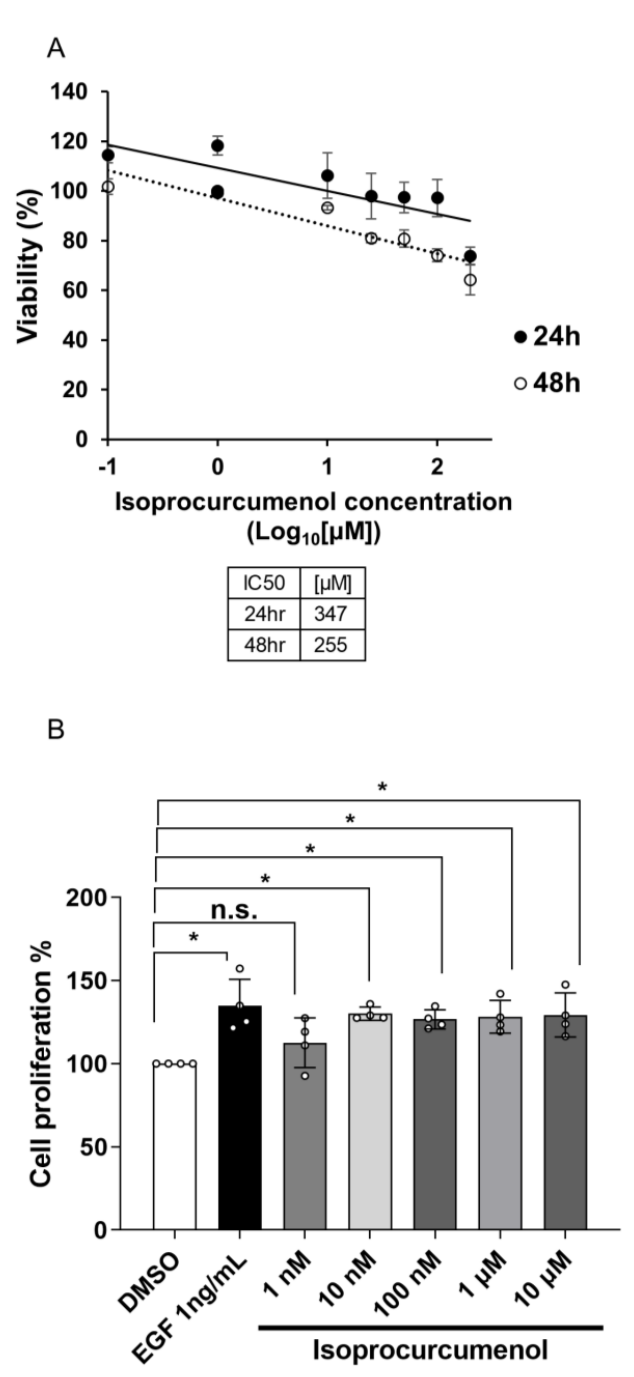
Figure 2. Measuring the concentrations of isoprocurcumenol that induce cell proliferation. ( A ) Measuring the toxicity of IPC on HaCaT cells. HaCaT cells were treated with different concentrations of IPC (0 nM, 100 nM, 1 μM, 10 μM, 25 μM, 50 μM, 100 μM, or 200 μM) for 24 or 48 h. MTT assay was performed to measure the viability of HaCaT cells. DMSO was used as a negative control ( n = 4). n.s., not significant, * p < 0.05; unpaired Student’s t test; error bars indicate SEM. ( B ) Measuring the proliferation of HaCaT cells induced by IPC. HaCaT cells were treated with different concentrations of IPC (1 nM, 10 nM, 100 nM, 1 μM, or 10 μM) for 24 h. Cell Counting Kit-8 (CCK-8) was used to measure the proliferation of IPC-treated HaCaT cells. DMSO was used as a negative control, while EGF (1 ng/mL) was used as a positive control ( n = 4). n.s., not significant, * p < 0.05; one-way ANOVA; error bars indicate SEM.